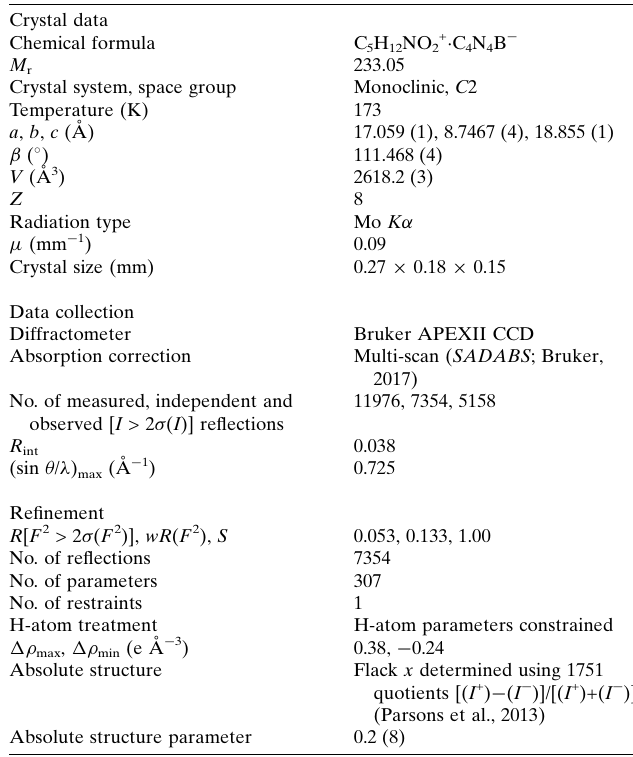
Table 1 Hydrogen-bond geometry (A˚ , (cid:4) ).